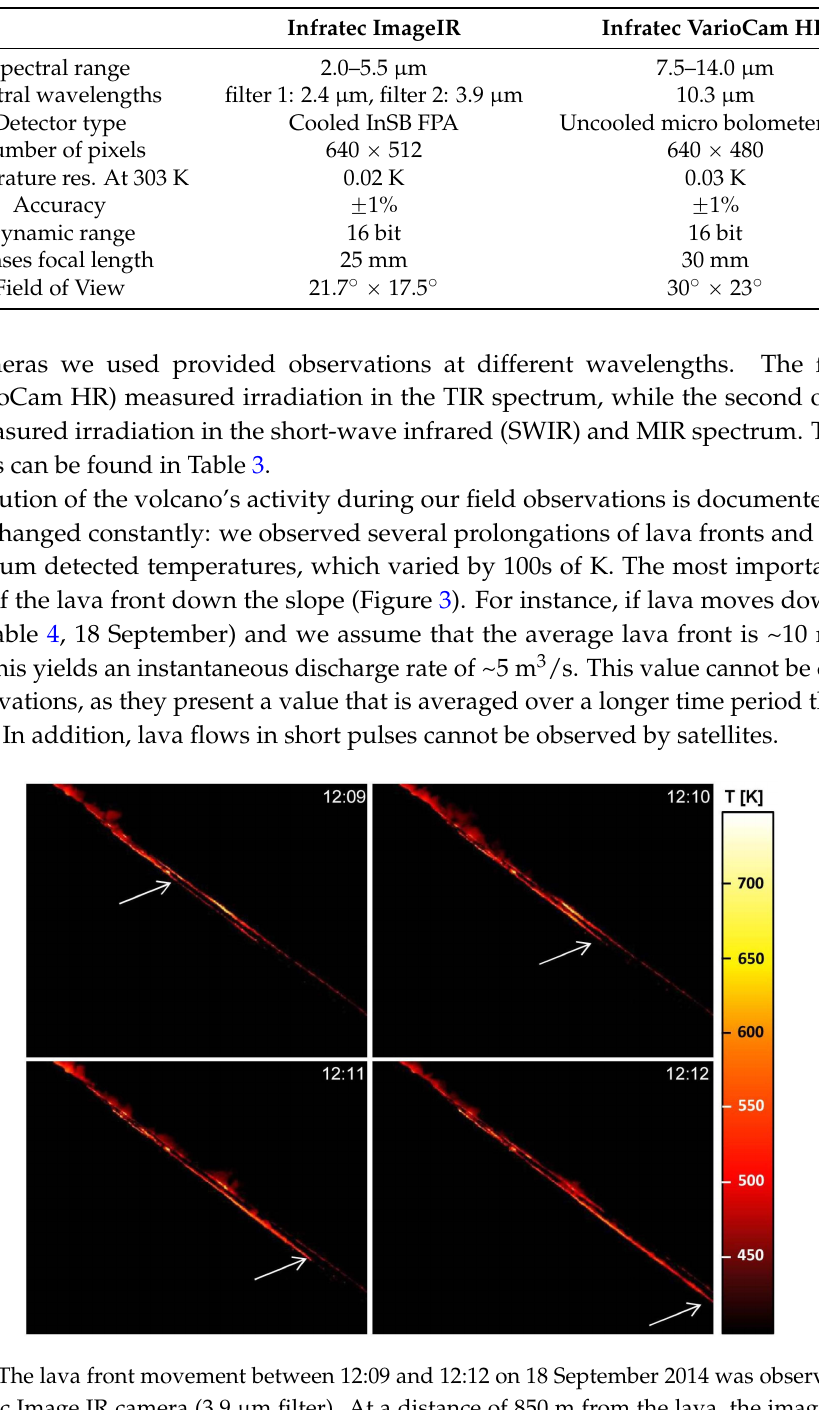
Table 3. Main characteristics of thermal cameras.